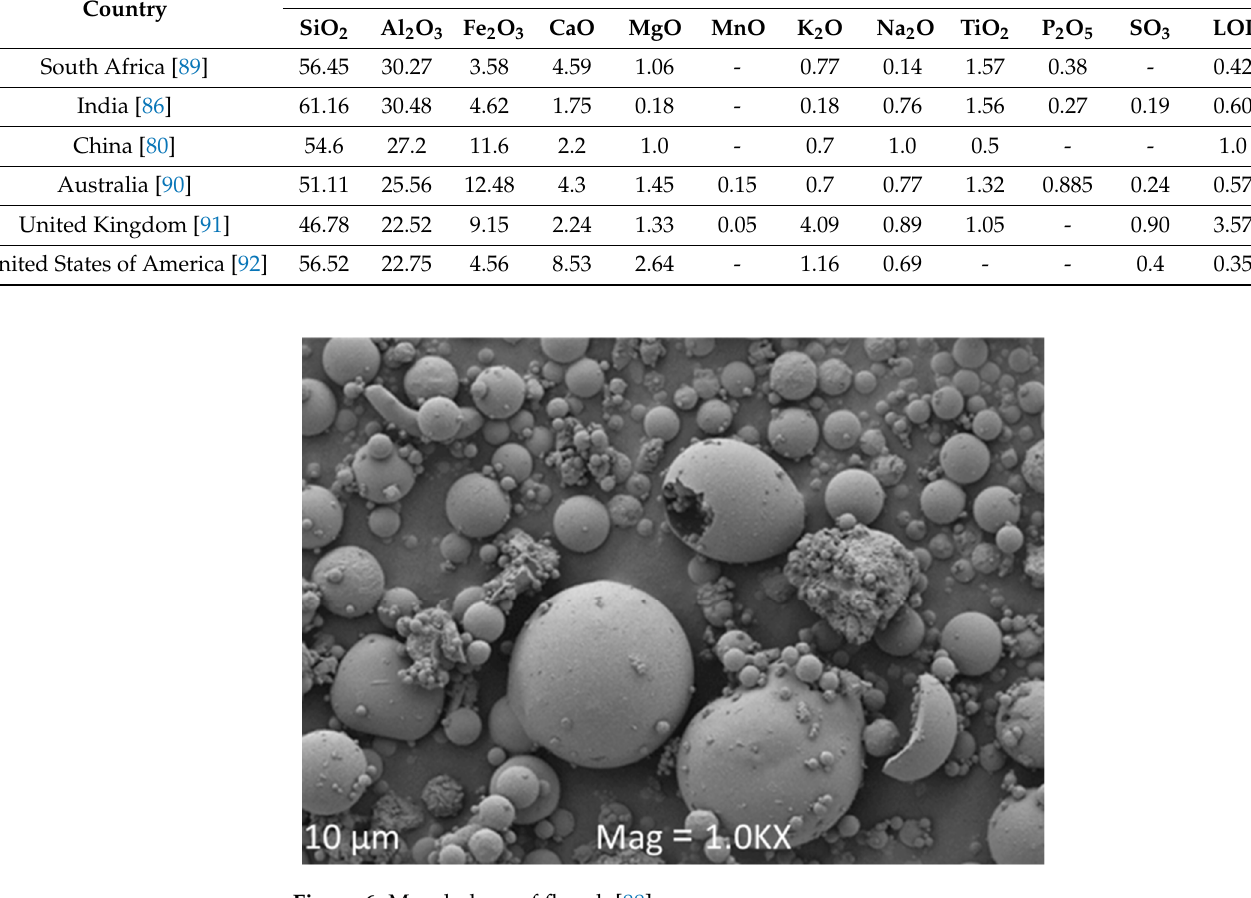
Figure 6. Morphology of fly ash [88].